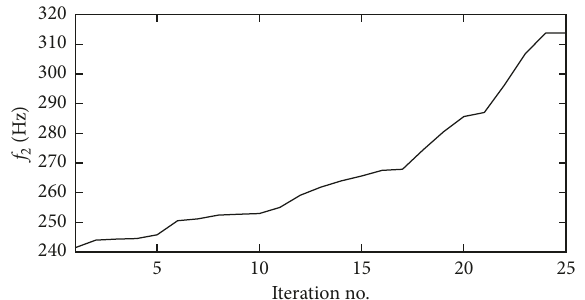
Figure 12: Optimization process of Model 2.